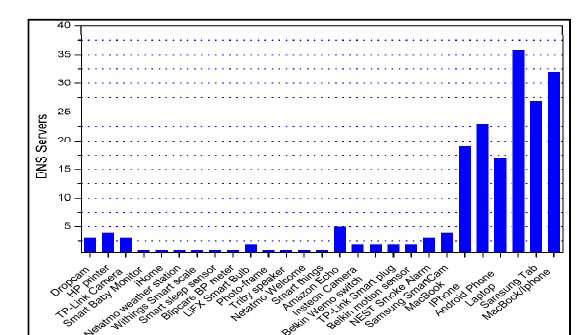
Fig. 8: Number of DNS servers used by a